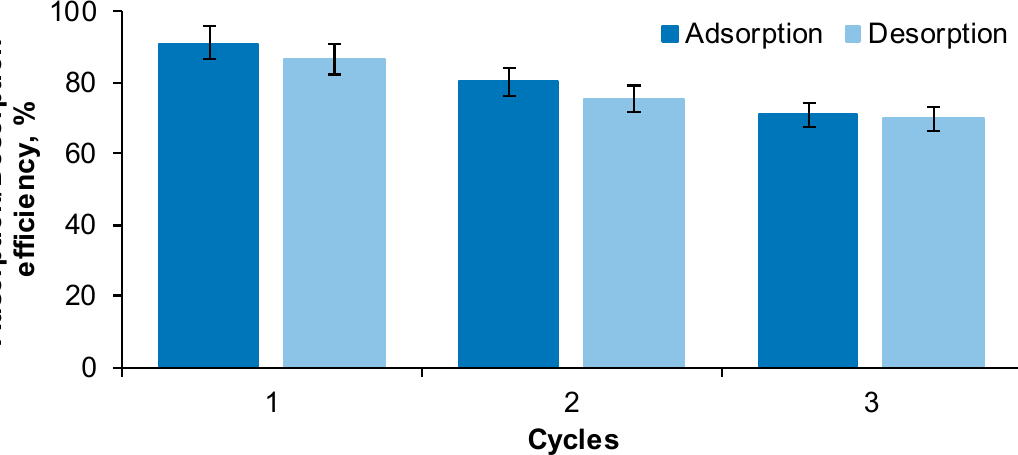
Figure 6. Adsorption/desorption e ffi ciency of Reactive Black 5 dye on/from the prepared adsorbent (Adsorption conditions: RB volume: 30 mL, RB initial concentration: 30 mg/L, adsorbent amount: 3 g, contact time: 6 h, temperature: 30 °C; Desorption conditions: eluent volume: 30 mL, eluent concen- tration: 1 M, adsorbent amount: 3 g, contact time: 6 h, temperature: 40 °C).